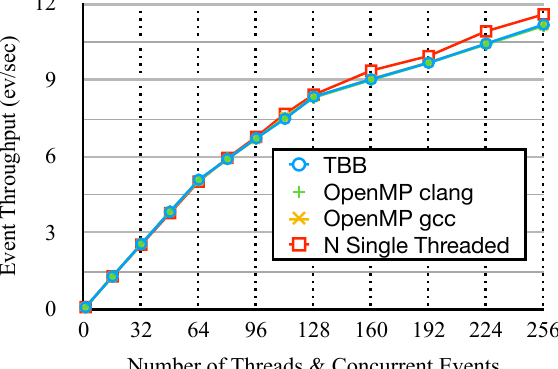
Fig. 3. Event throughput as a function of utilized cores where all Modules are able to run